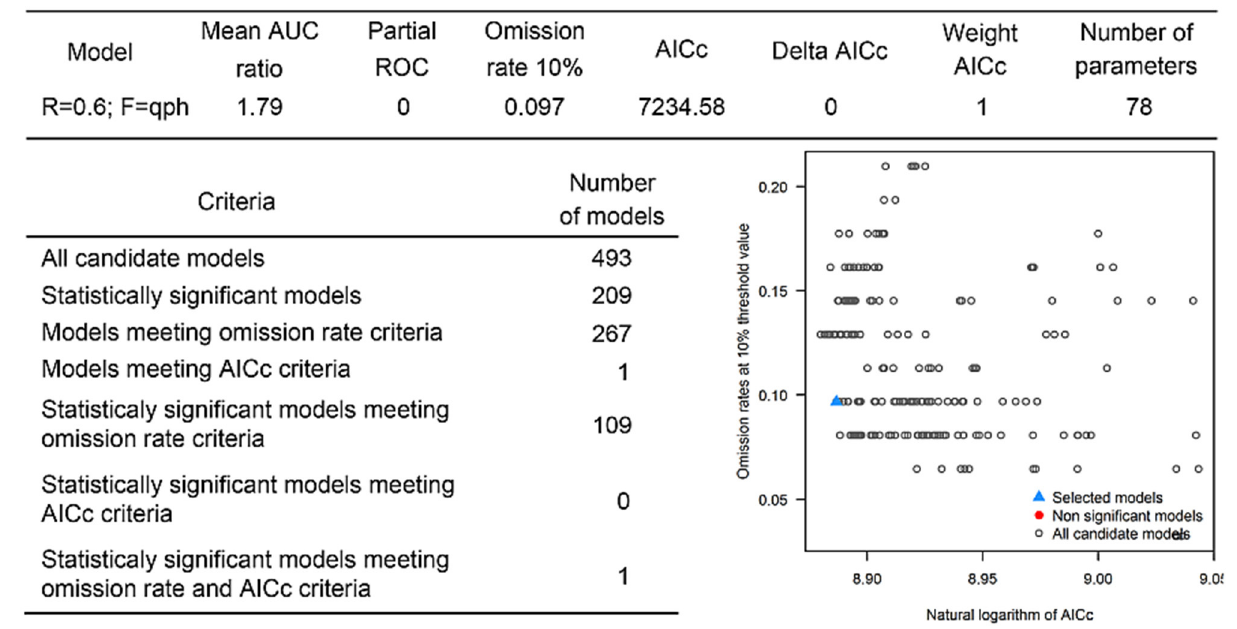
FIGURE 6 | Model calibration statistics for hosts and